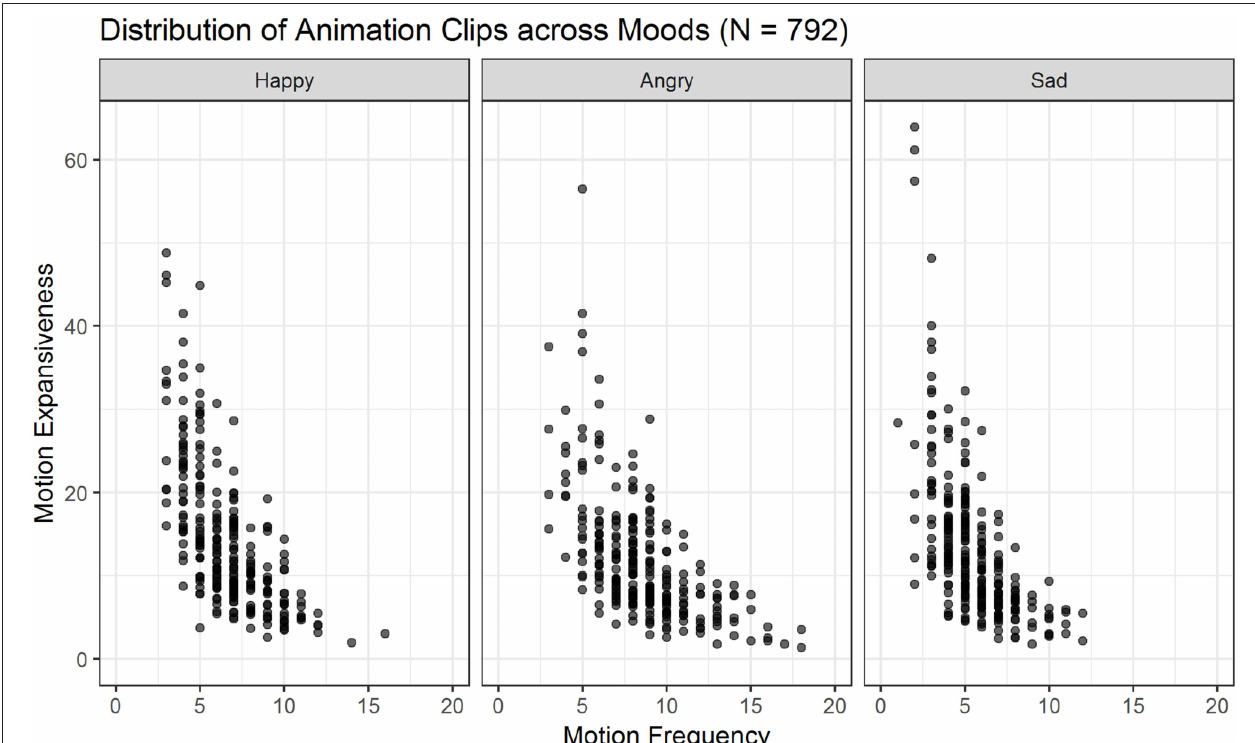
FIGURE 6 | Scatter plots showing the relations of motion frequency and motion expansiveness for all three moods. Darker areas indicate the overlap of multiple animation-files. Sad movements show the highest values for motion expansiveness, while angry movements show the highest motion frequency values.